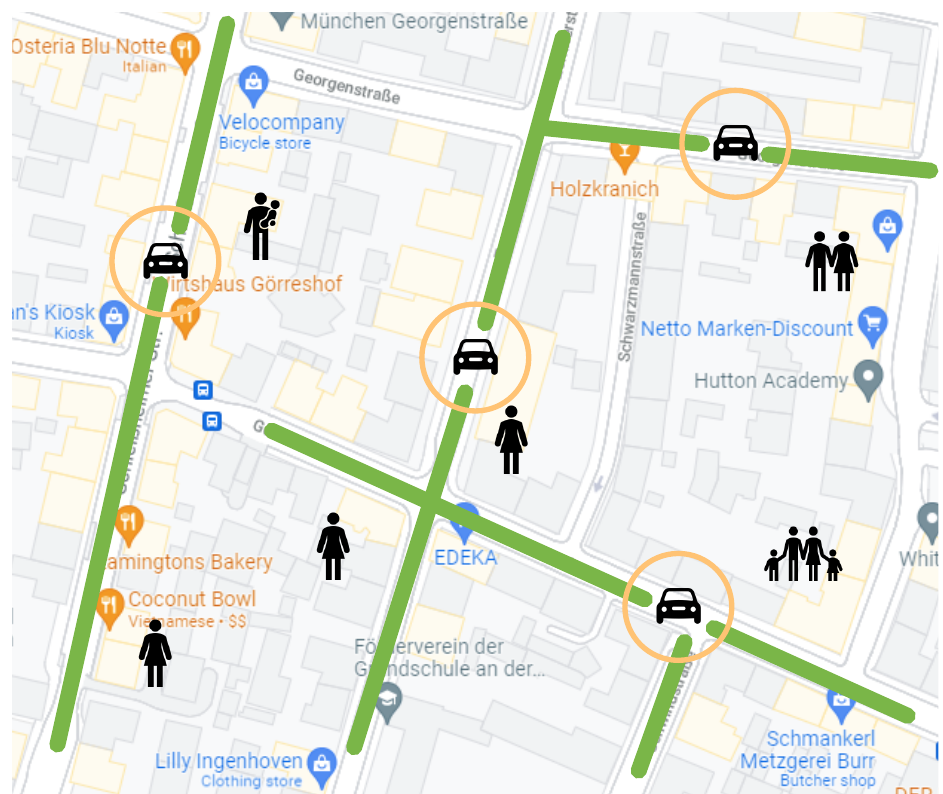
Figure 2. An illustration of a virtual area of a station on streets.